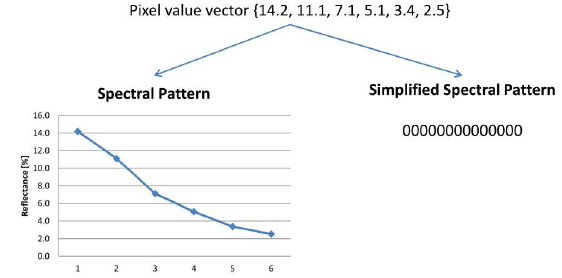
Figure 2. Example of a transformation of the spectral pattern into a simplified spectral pattern.